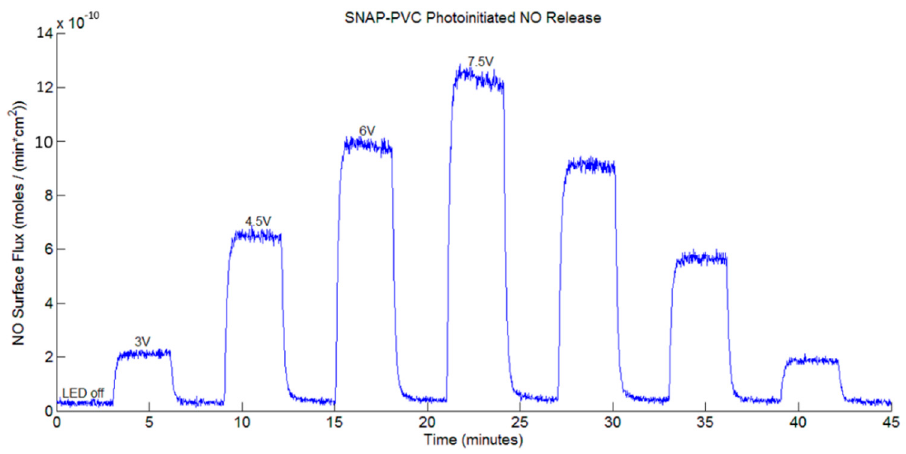
Figure 3. Representative nitric oxide (NO) release profile of a SNAP-PVC film (5.5 mm dia., 0.1 mm thick disc) from photoinitiated NO release using a 460 nm LED with varied applied voltages, resulting in varied levels of light energy impinging upon the film while the resistance was held at 130 Ω .